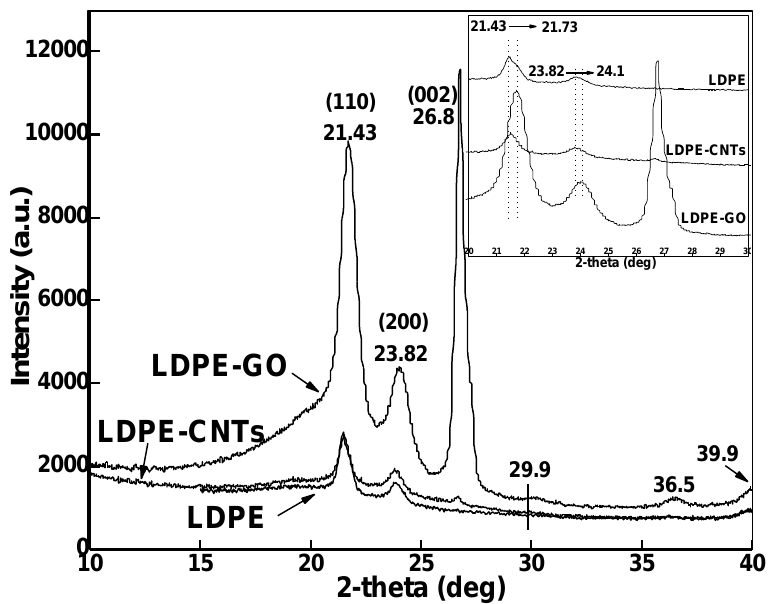
Figure 3 . X-ray diffraction patterns of pure LDPE, LDPE-CNTs, and LDPE-GO. INSET image is provided to illustrate peak shift.